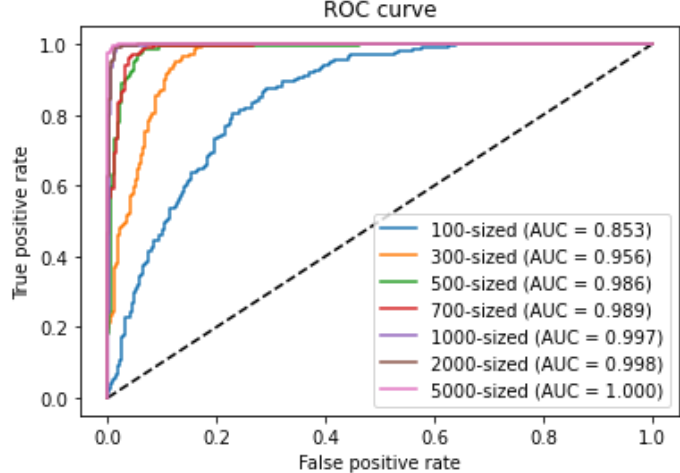
Figure 6. ROC curves and AUC values of the models for each sample size.